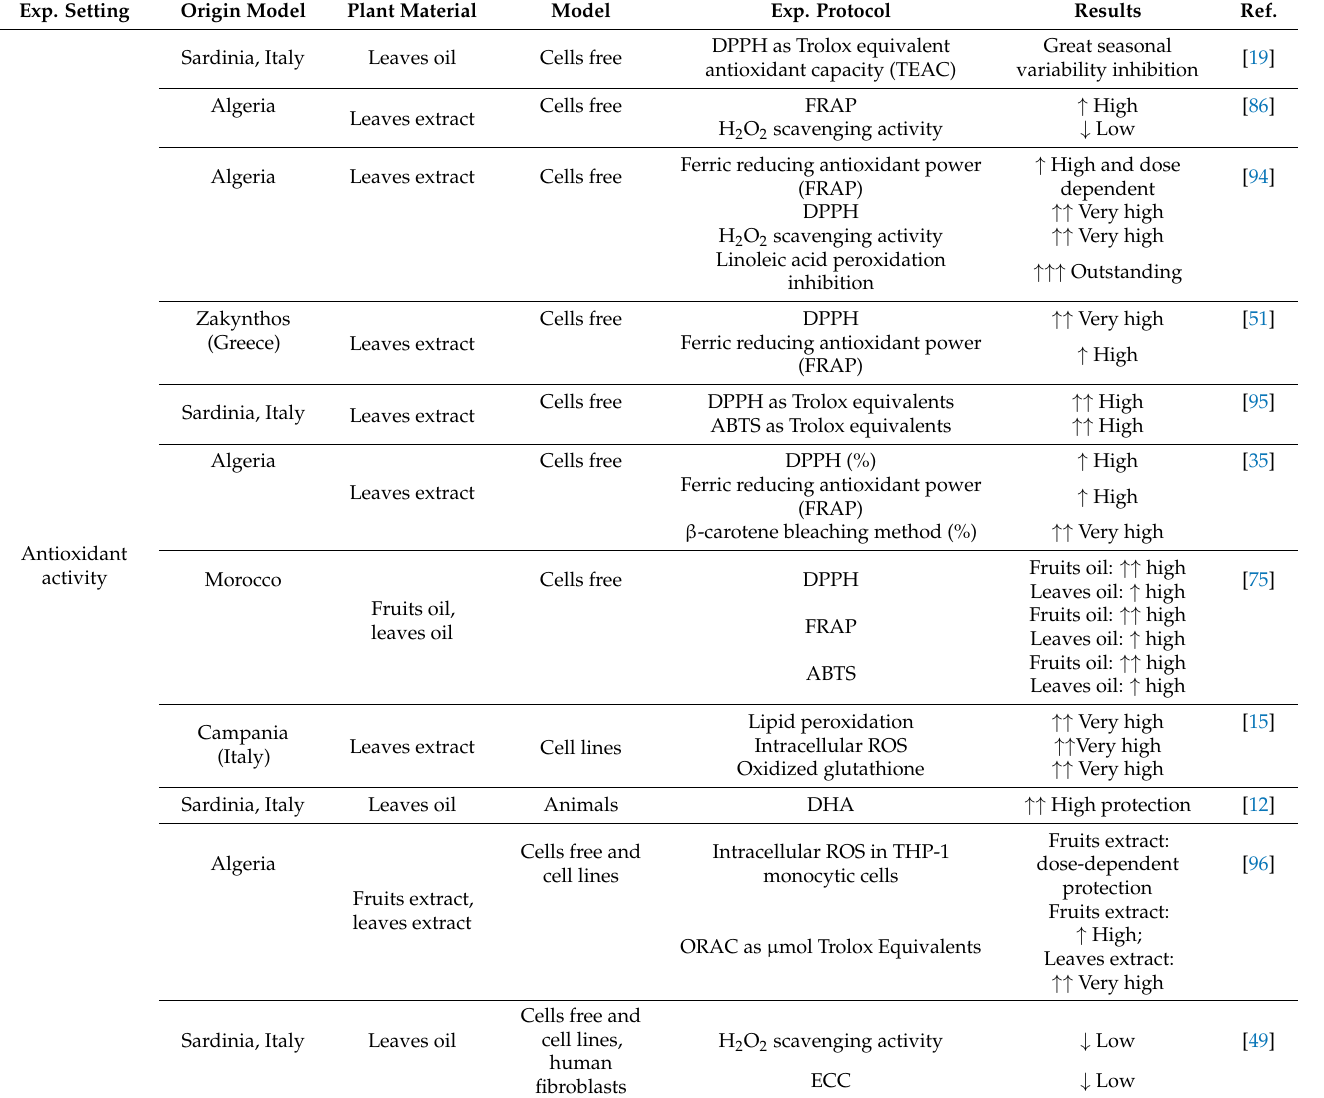
Table 4. Antioxidant and anti-inflammatory activity of Pistacia